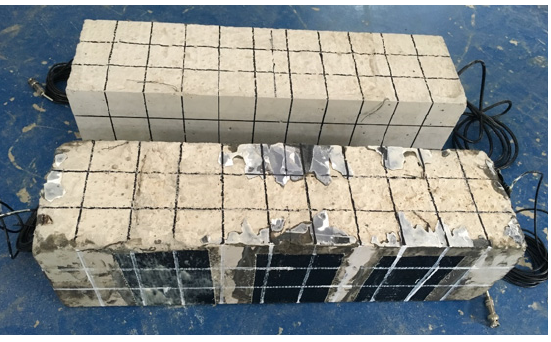
Figure 3. Specimens of concrete beams strengthened with and without CFRP fabric. Table 1. The material properties of the test specimens and the CFRP.